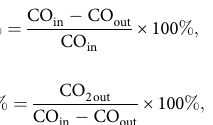
The other 6 types of Co-SCRs were also obtained using the same printing processes. The fabrication processes of Co-SCR and Ni-SCR were performed by Shanghai Consu Metal Materials Co., Ltd. in China. To further activate the catalytic centers, the SCRs were simply pretreated before